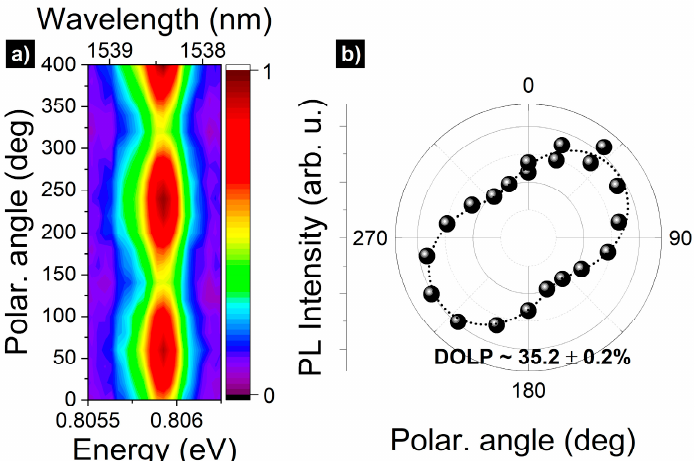
Figure 3. ( a ) Polarization-resolved µ PL spectral map for CX emission; ( b ) the intensity of µ PL polarization for CX line. The dashed line is a fit (Equation (1)) to the experimental data, indicating approximately 35% of the DOLP value.